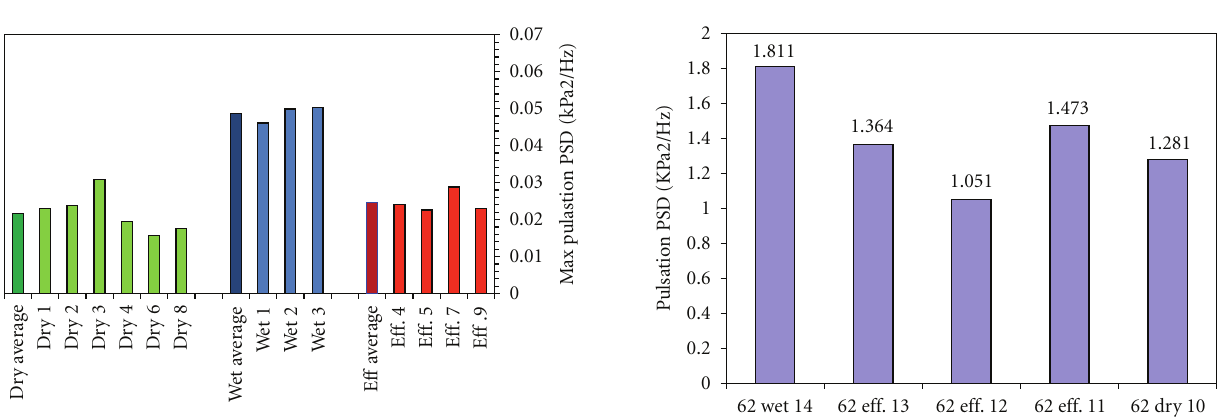
Figure 18: Peak pulsation energy for dry, wet, and e ff ervescent injection at 62,000 RPM.